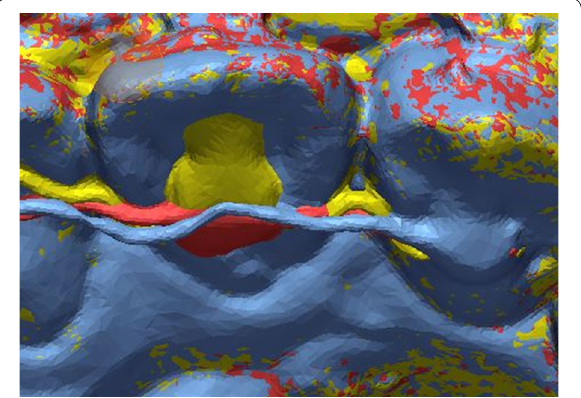
Fig. 10 Superimposition of three types of retainers simultaneously (yellow: custom‑cut group, blue: custom‑bent group, red: manual